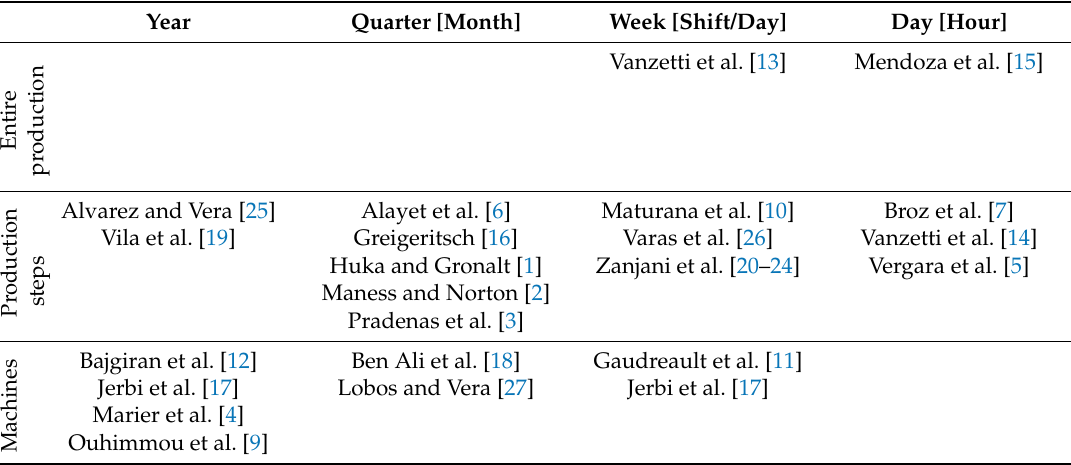
Table 3. The existing literature structured along the two dimensions, degree of aggregation and planning